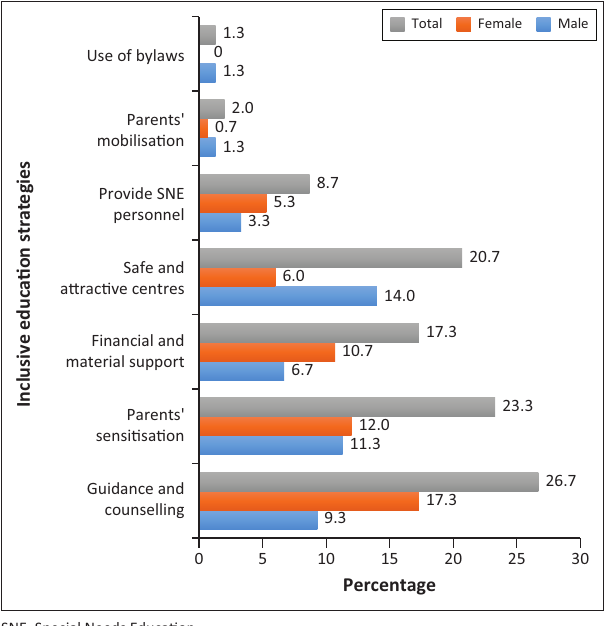
FIGURE 2: Inclusive home-based early education promotion strategies preferences by